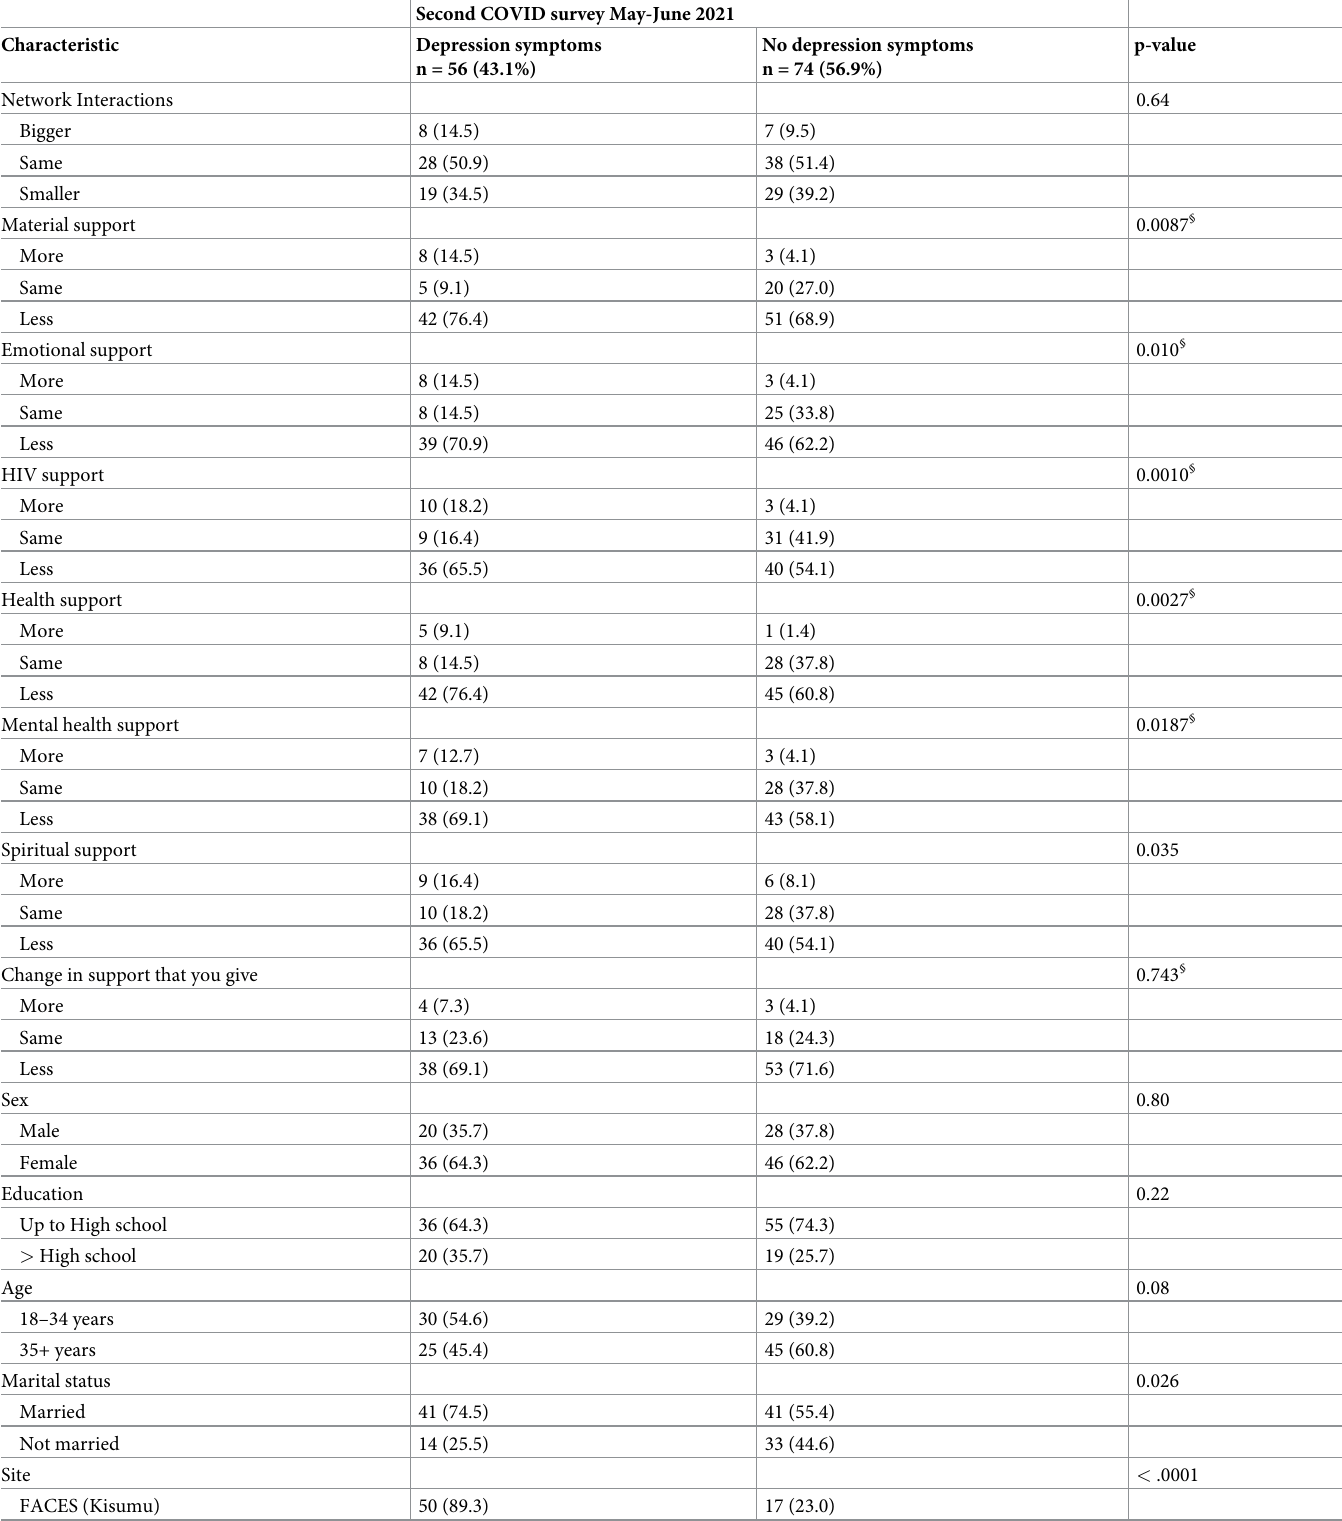
Table 4. COVID-19 survey: Social support and demographic factors associated with depressive symptoms (PHQ-2 �